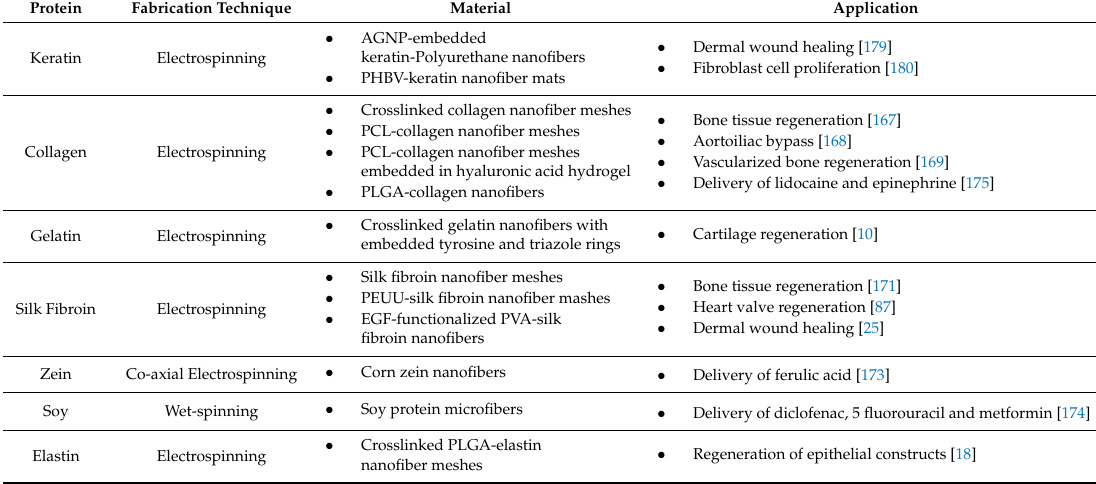
Table 2. Overview of applications of protein-based nanofibers in